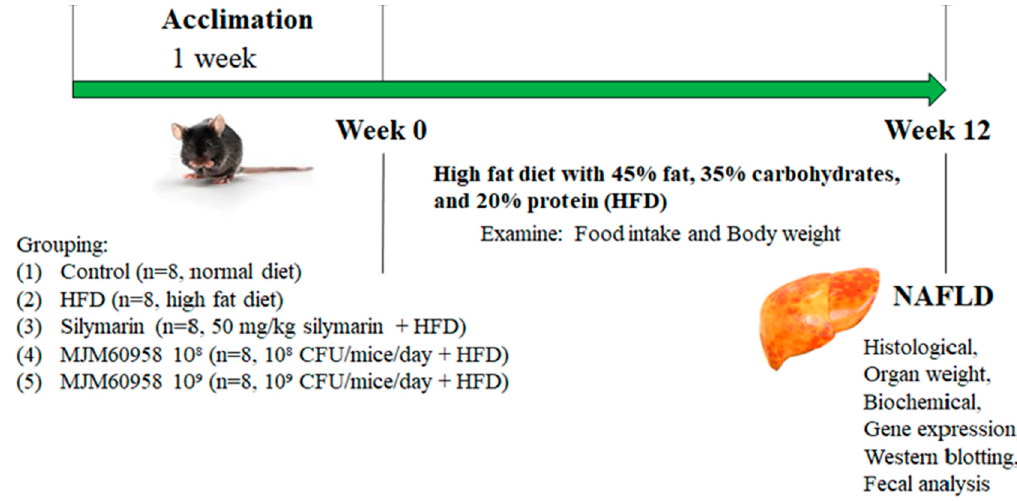
Figure 8. Animal experiment design.